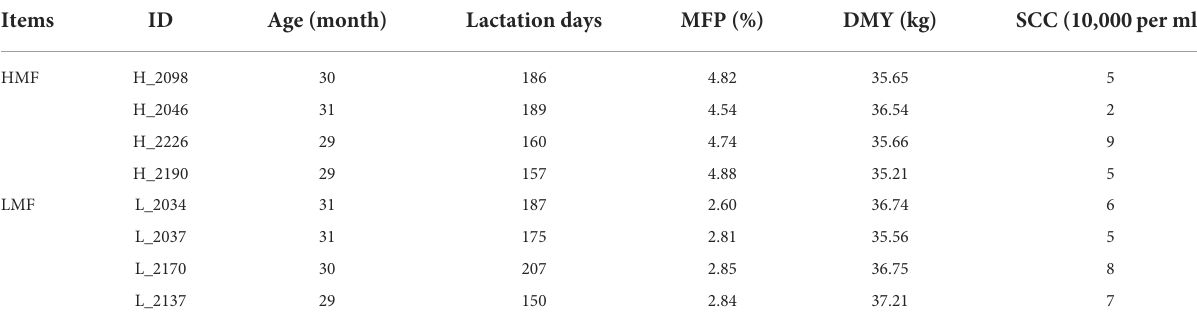
TABLE 1 High and low milk fat percentage and somatic cell count of eight non-sibling Holstein cows.